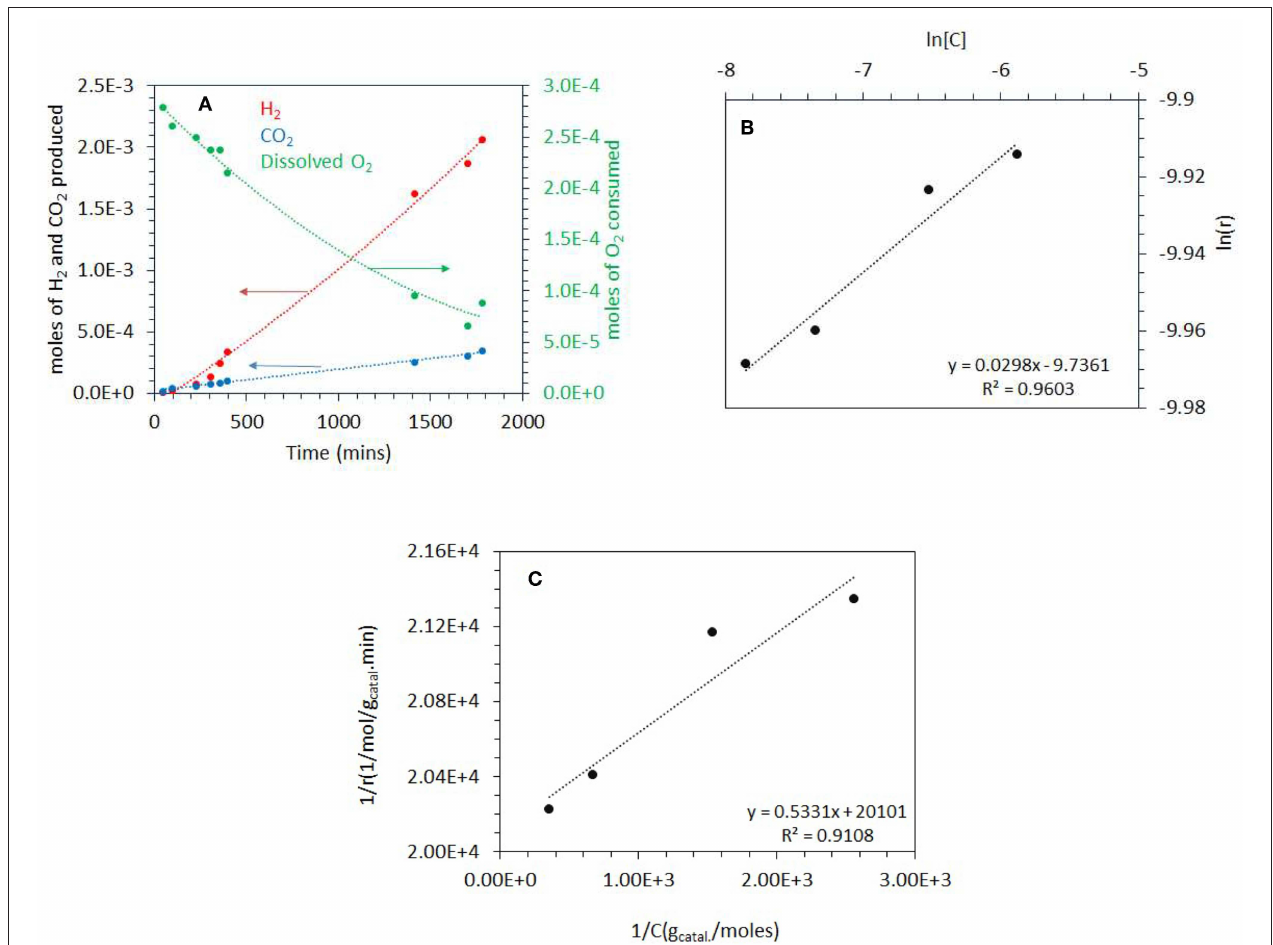
FIGURE 5 | (A) Photoreaction performed at 0.2 atm P O2 with 5 vol.% (0.67M) ethylene glycol and 2mg of 0.1 wt.% Ag − 0.3 wt.% Pd/TiO 2 (anatase) catalyst. (B) ln [C] vs. ln(r) where C is the concentration of dissolved oxygen and r is the rate of ethylene glycol disappearance. The photoreactions were performed at 0.03–0.20 atm P O2 . The ethylene glycol concentration was 5 vol.% (0.67M) and 2mg of 0.1 wt.% Ag − 0.3 wt.% Pd/TiO 2 (anatase) catalyst was used for the reaction. (C) 1/ r (g catal .min/mol) vs. 1/ C (g Catal. /mol), where C is the concentration of dissolved oxygen and r is the rate of ethylene glycol disappearance. The photoreaction were performed from 0.03 to 0.20 atm P O2 . The ethylene glycol concentration was 5 vol.% (0.67M) and 2mg of 0.1 wt.% Ag − 0.3 wt.% Pd/TiO 2 (anatase) catalyst was used for the